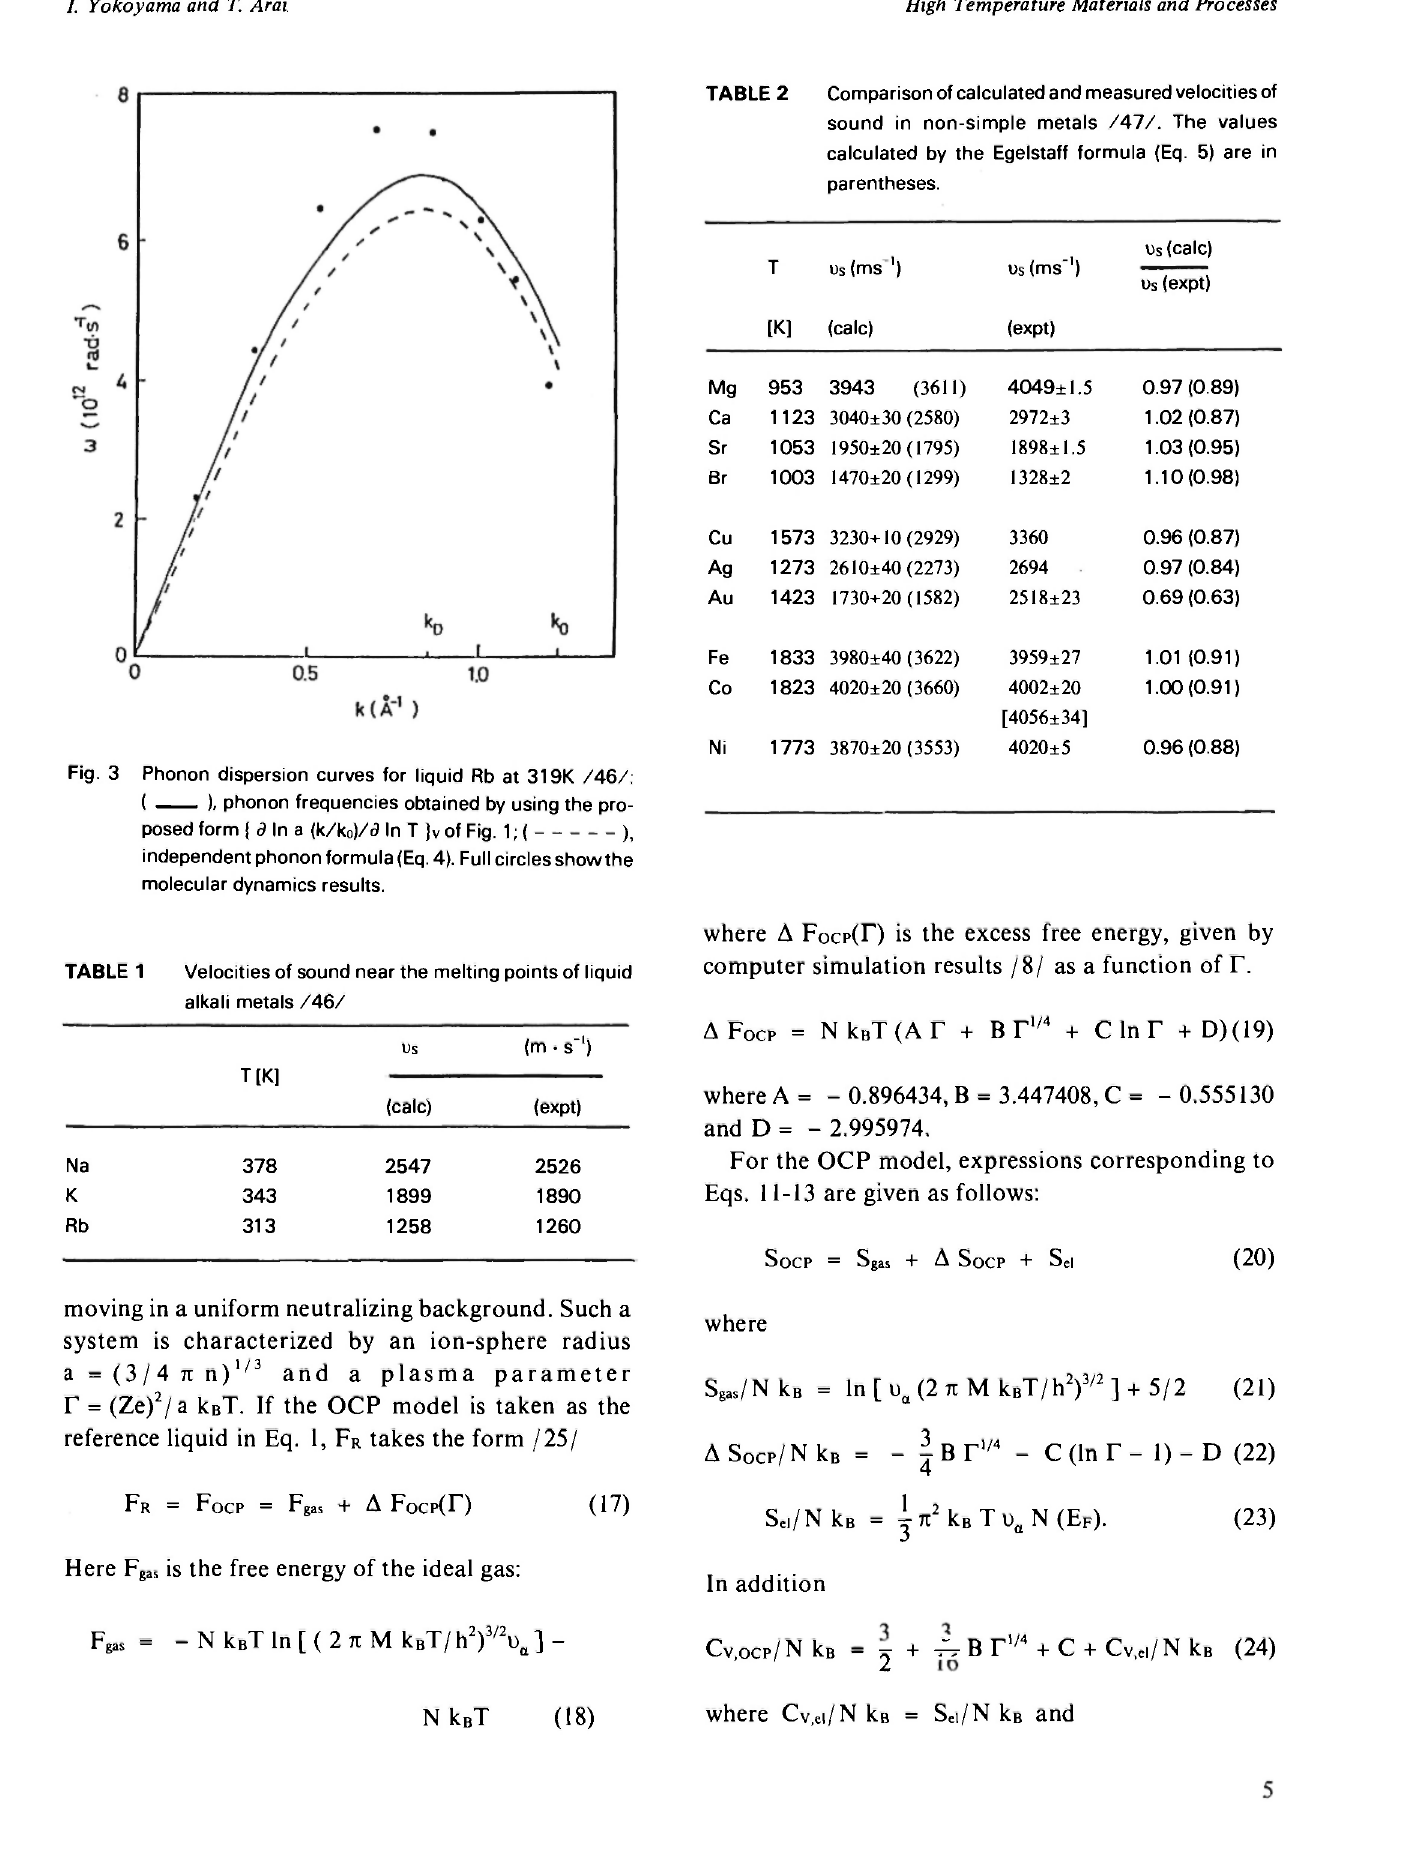
Comparison of calculated and measured velocities of sound in non-simple metals /47/. The values calculated by the Egelstaff formula (Eq. 5) are in